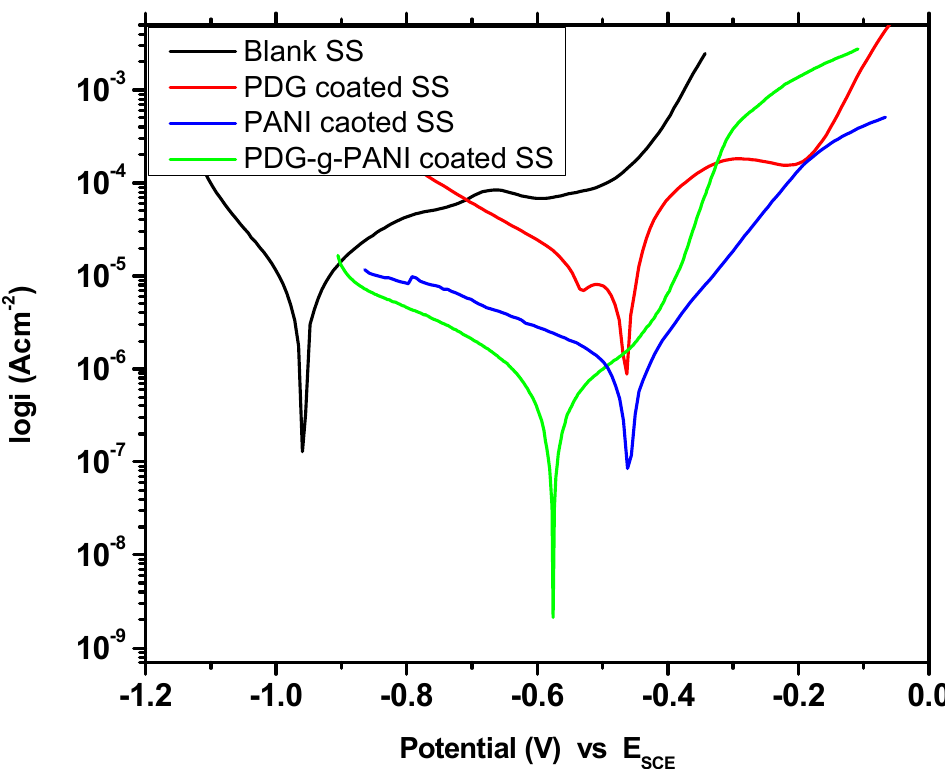
Figure 10. Tafel plot of uncoated SS, PANI-coated and PDG-g-PANI-coated SS. Table 3. Comparison of essential corrosion kinetic parameters of uncoated SS, PANI-coated, and PDG-g-PANI-coated SS in 3.5% NaCl